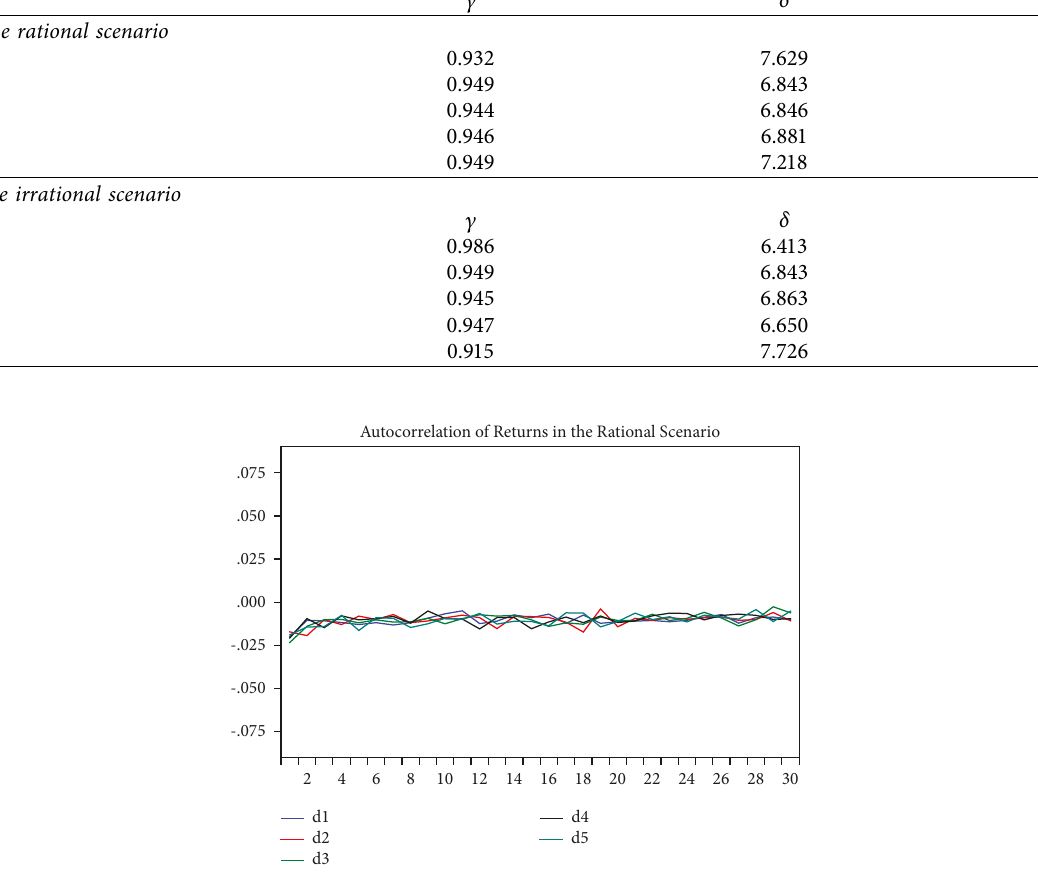
Figure 3: Autocorrelation of returns in the rational scenario. This figure shows the autocorrelation of returns in the rational scenario. The parameters of price determination and the fundamental price used in simulations are calibrated. d represents the magnitude of behavioral hesitation and decision rigidity, which ranges from 1 to 5. The lengths of the lags range from 1 to 30.